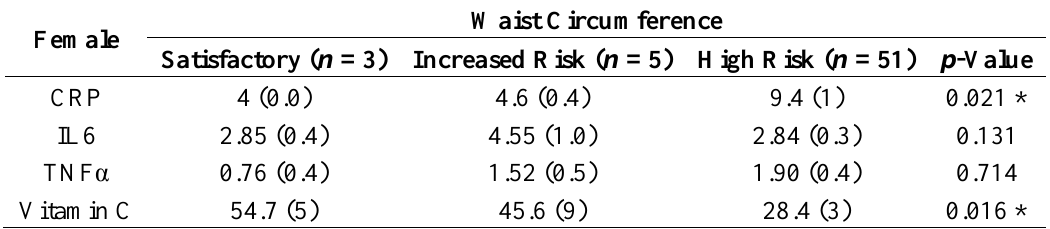
Table 5. Antioxidants and markers of oxidative damage and inflammation according to the WHO waist circumference cut-off-points for female subject (mean